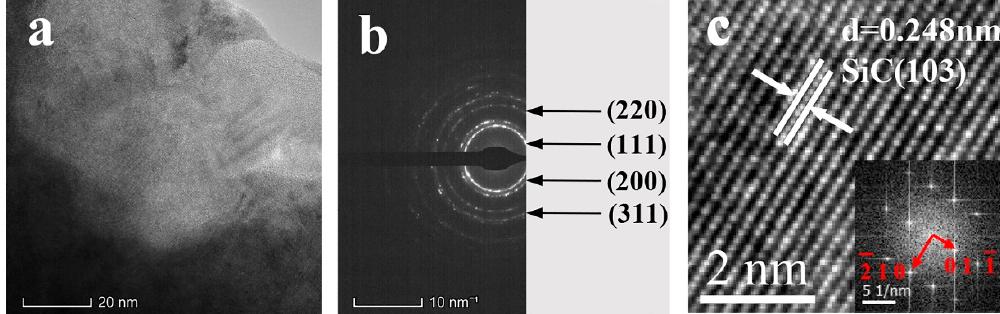
Figure 5. ( a ) Bright field image of the duplex nanoparticles reinforced Ni–Mo coating; ( b ) diffraction ring of the metal matrix; and ( c ) HR-TEM image of the nanoparticles.